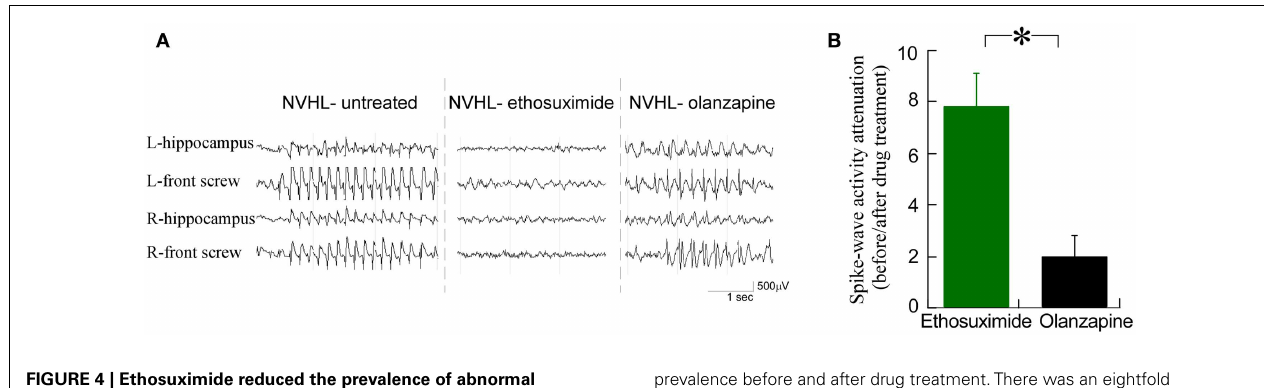
FIGURE 4 | Ethosuximide reduced the prevalence of abnormal spike-wave activities in NVHL rats . (A) Raw EEG traces. Ethosuximide reduced the occurrence of spike-wave activity while olanzapine did not. (B) Quantification of the spike-wave activity